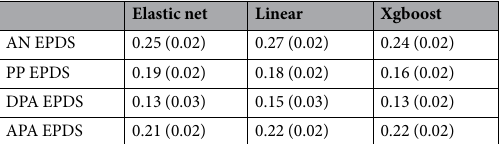
Table 8. Ten-fold cross validated correlation of prediction of EPDS scores with original scores based on predictors using penalised linear regression (elastic net), linear regression (linear), and extreme gradient boosting (xgboost). In brackets the standard deviation based on 20 random iterations. AN = antenatal; PP =